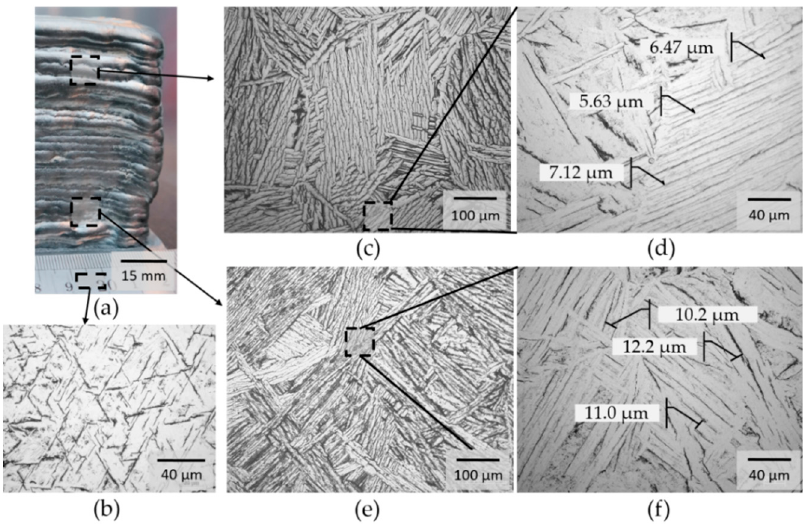
Figure 4. Overview and optical micrographs of the part at different locations, in: As-welded condition, ( a ) overview of the AM part, ( b ) Ti6Al4V build plate, ( c ) structure of the upper layer, ( d ) detail structure of the upper layer, ( e ) structure of the bottom layer, ( f ) detail structure of the bottom layer.